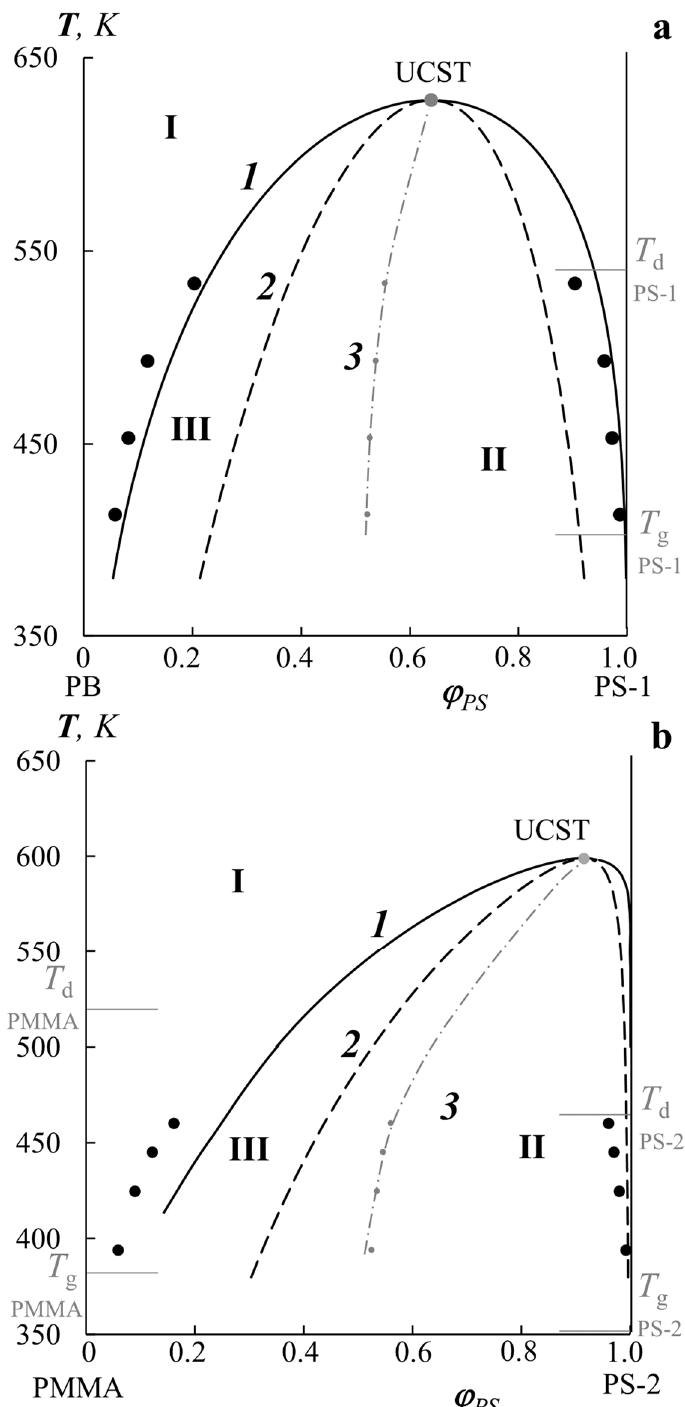
Figure 7. Generalized phase diagrams for PB–PS-1 ( a ) and PMMA–PS-2 ( b ) systems with experimen- tal data on the components’ solubility (black dots), calculated binodal (solid lines 1) and spinodal (dashed lines 2) curves separating the region of homogeneous states (I), the region of labile structures (II), and the region of metastable states (III). Curve 3 corresponds to Alekseev’s diameter. T d and T g correspond to the degradation and glass transition temperatures of the components,